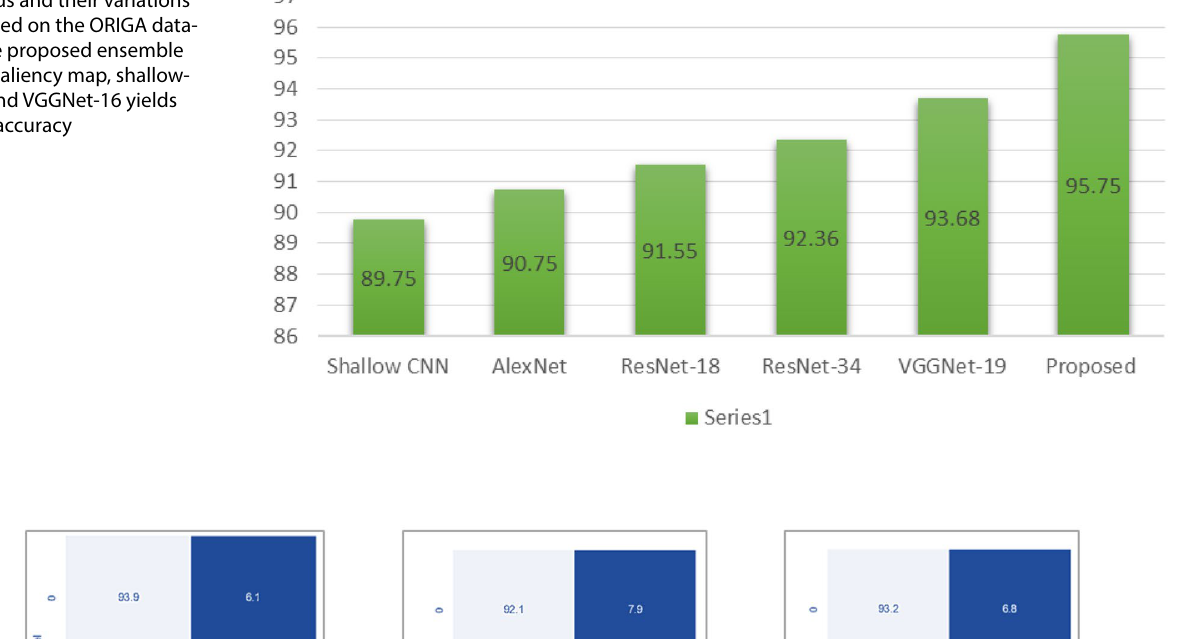
Fig. 6 Accuracy comparison of various transfer learning methods and their variations evaluated on the ORIGA data- set. The proposed ensemble of the saliency map, shallow- CNN, and VGGNet-16 yields better accuracy